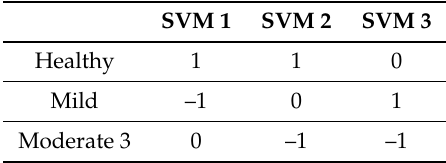
Table 1. Error-correcting output coding (ECOC) SVM coding design.